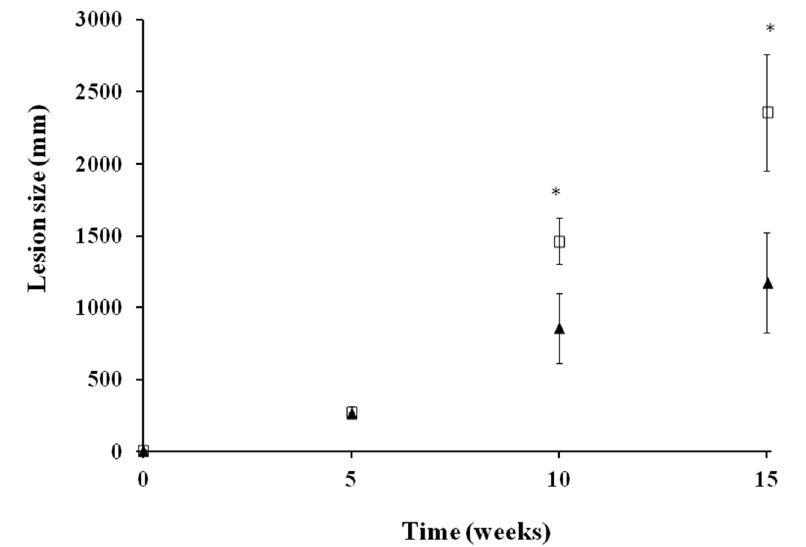
Figure 1. In vivo antileishmanial efficacy of UA ointment against L. amazonensis in a chronic infection model of cutaneous leishmaniasis (CL) in Syrian hamsters. Disease progression was monitored at week 0, 5, 10, and 15. After 35 days post-infection, UA ointment (0.2%) was administered once daily for 28 consecutive days in one of the groups. The other group received no treatment. Disease progression was monitored since the treatment was instaured at weeks 0, 5, 10, and 15. Lesion size (mean ± SD) is expressed as the difference between the diameter (mm) of the infected left hind paw and the non-infected right hind paw from each animal. Statistically significant differences ( p < 0.05) are expressed as: * (U-Mann–Whitney). Key: UA ointment at 0.2% (- -); untreated group (-□-).